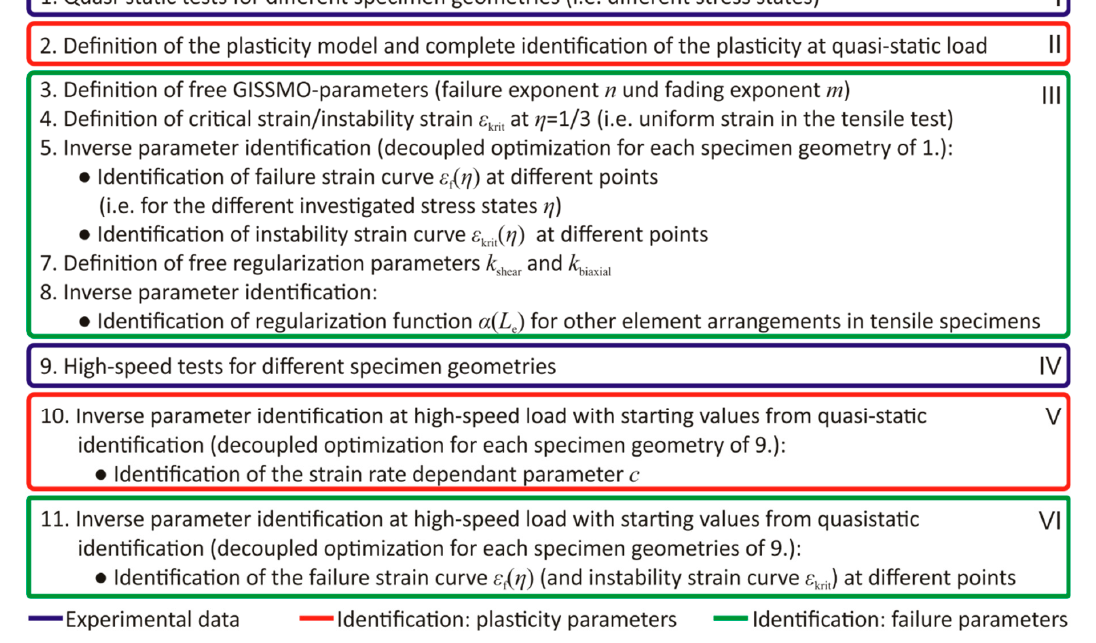
Figure 13. Procedure for identification of the material model.